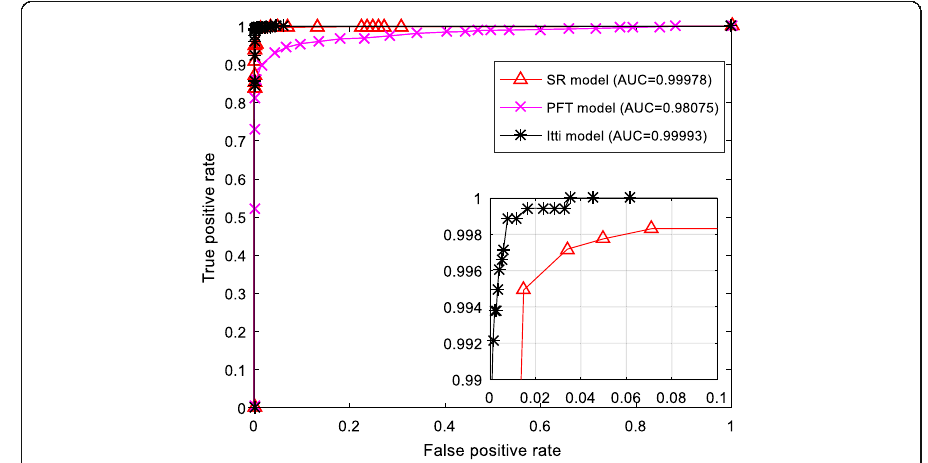
Fig. 8 ROC curves of different visual attention